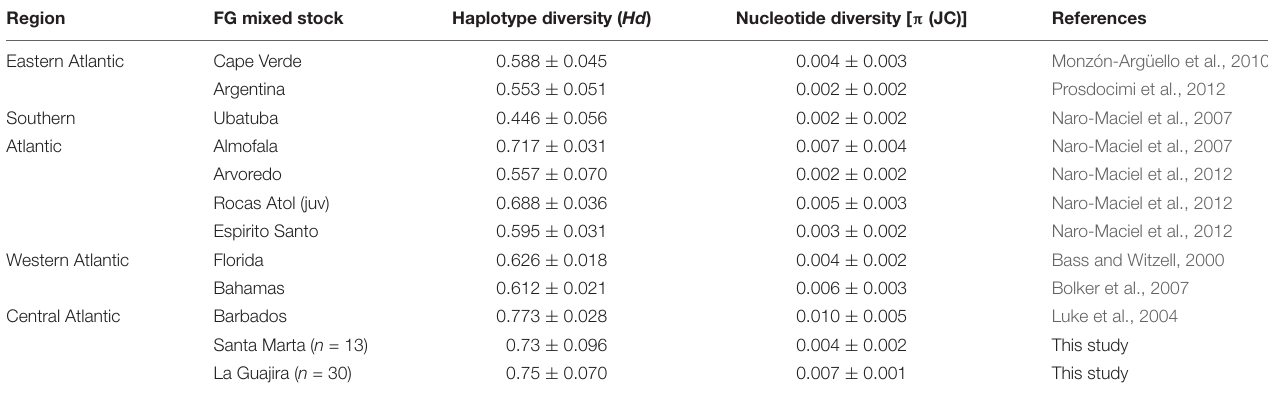
TABLE 1 | Genetic diversity estimates of Atlantic Ocean foraging aggregations of juvenile Chelonia mydas surveyed in this study and other studies, based on the variation at the mitochondrial Control Region.